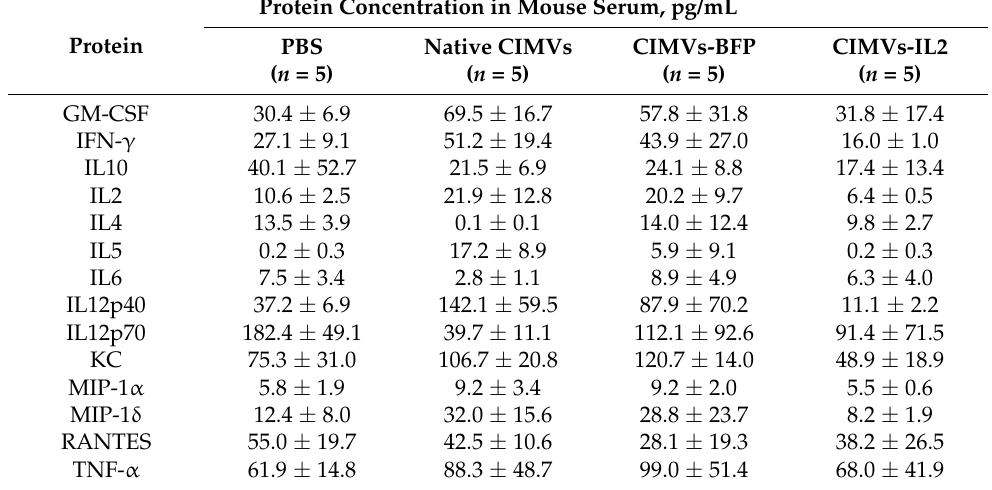
Table 2. The levels of cytokines/chemokines in the serum of mice 72 h after injection of 50 µ g (in